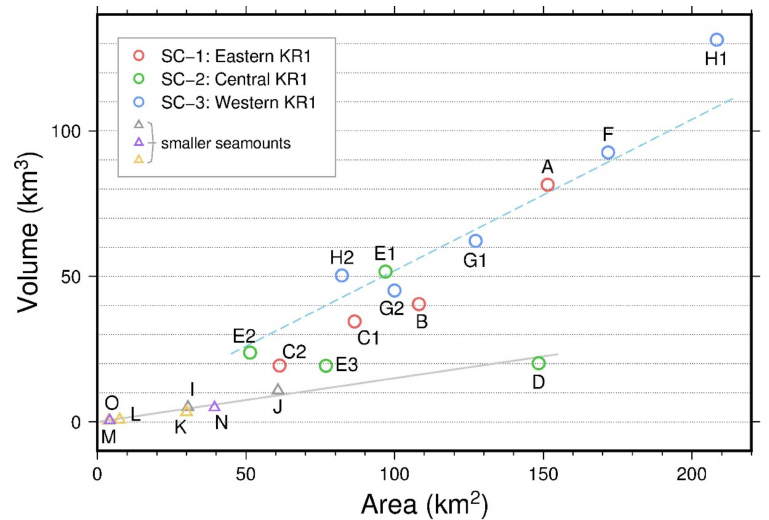
Figure 7. Basal area versus volume for each seamount. Seamounts can be divided into two groups by the linear relationship between their basal area and volume: a group following the trend of the dashed light-blue line and a group following the trend of the solid light-gray